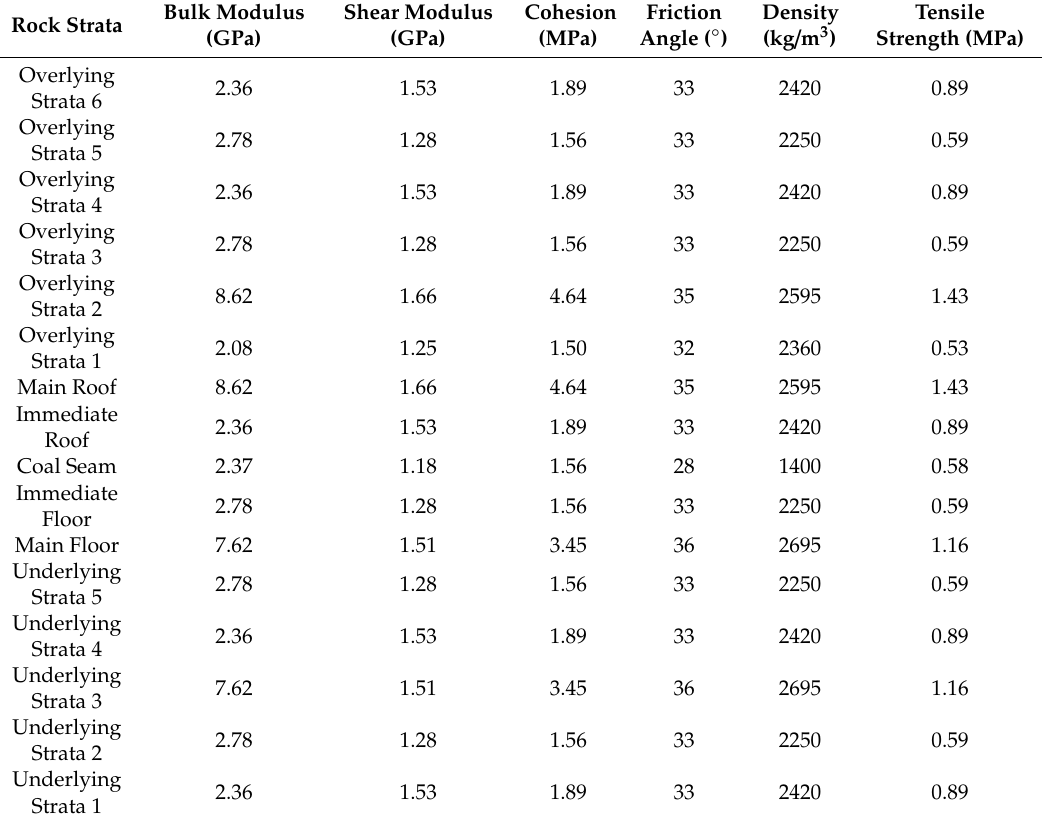
Figure 13. Configuration of the 3D model used in the numerical simulation. Table 3. Rock strata properties used in the numerical model.